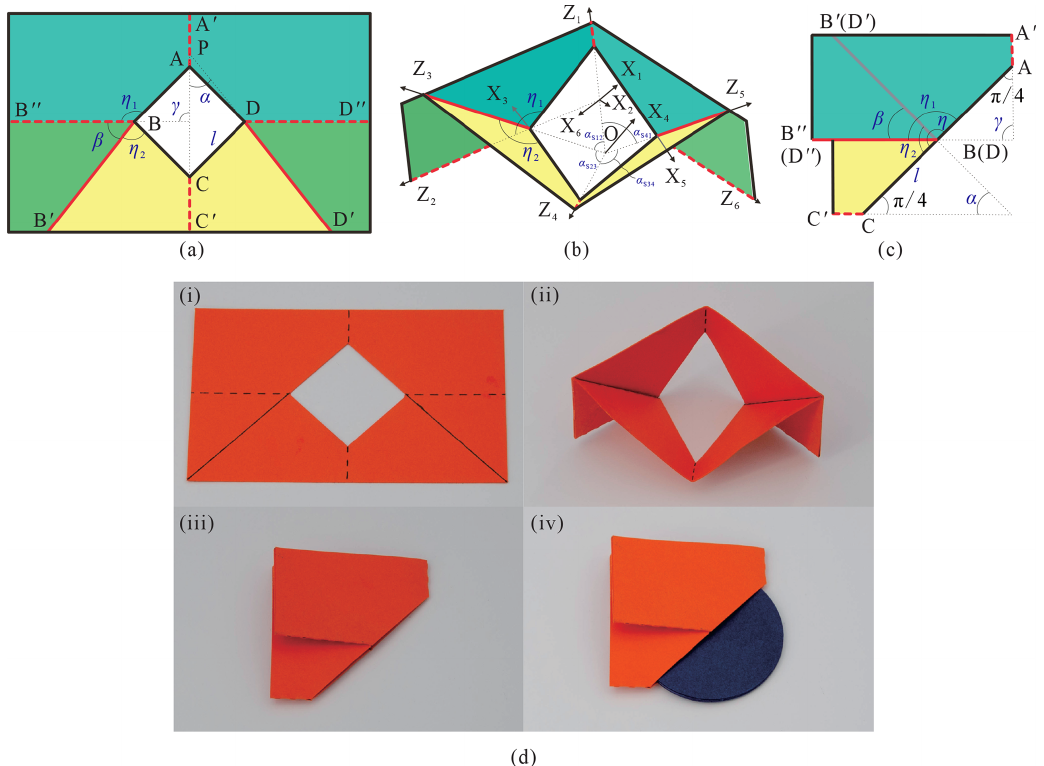
Figure 6. The six-crease pattern for scheme II with parameters α = π/ 4, β = π/ 4, γ = π/ 2, which is the solution from Tadashi Tokieda (a) at the deployed configuration, (b) at the folding configuration, and (c) at the fully folded configuration, demonstrated with (d) the folding sequence of a physical model.